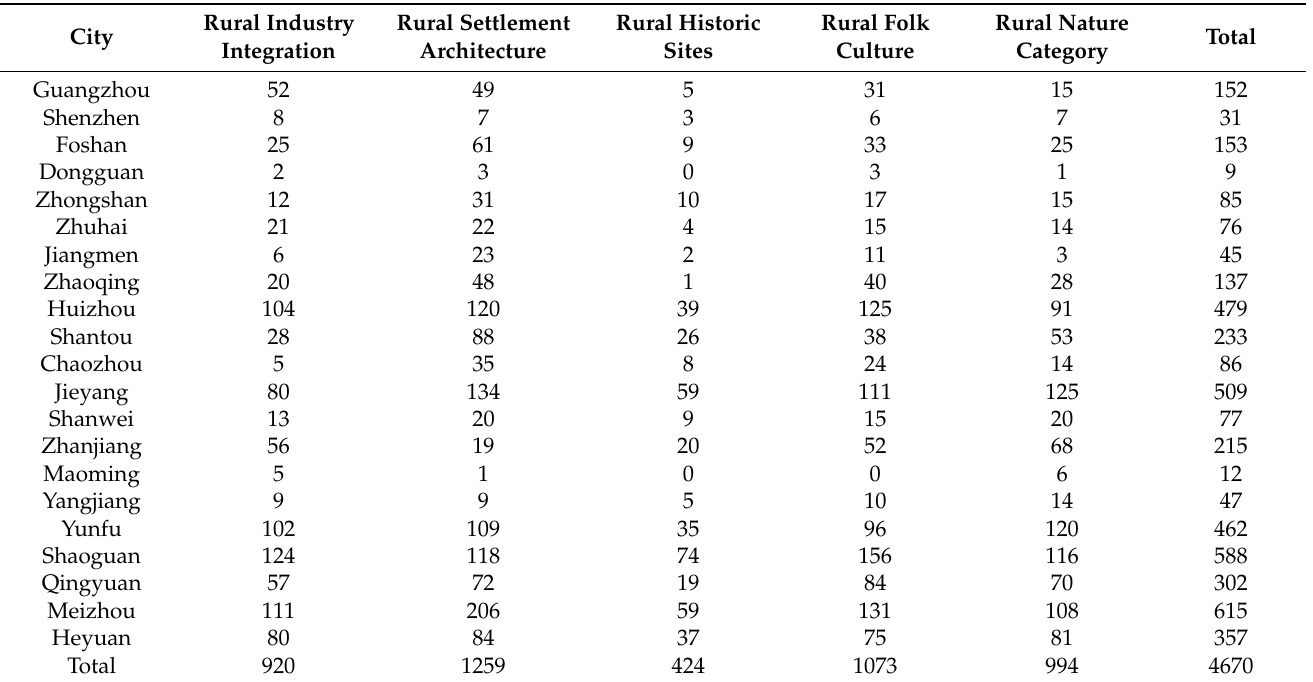
Table 1. Distribution of Rural Tourism Resources Development in 21 Prefecture-level Cities of Guangdong